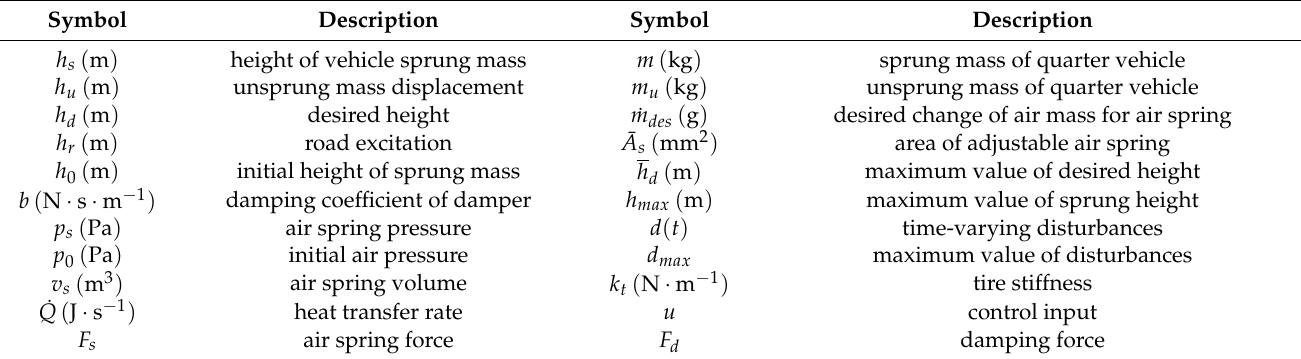
Table 1. Symbols and their